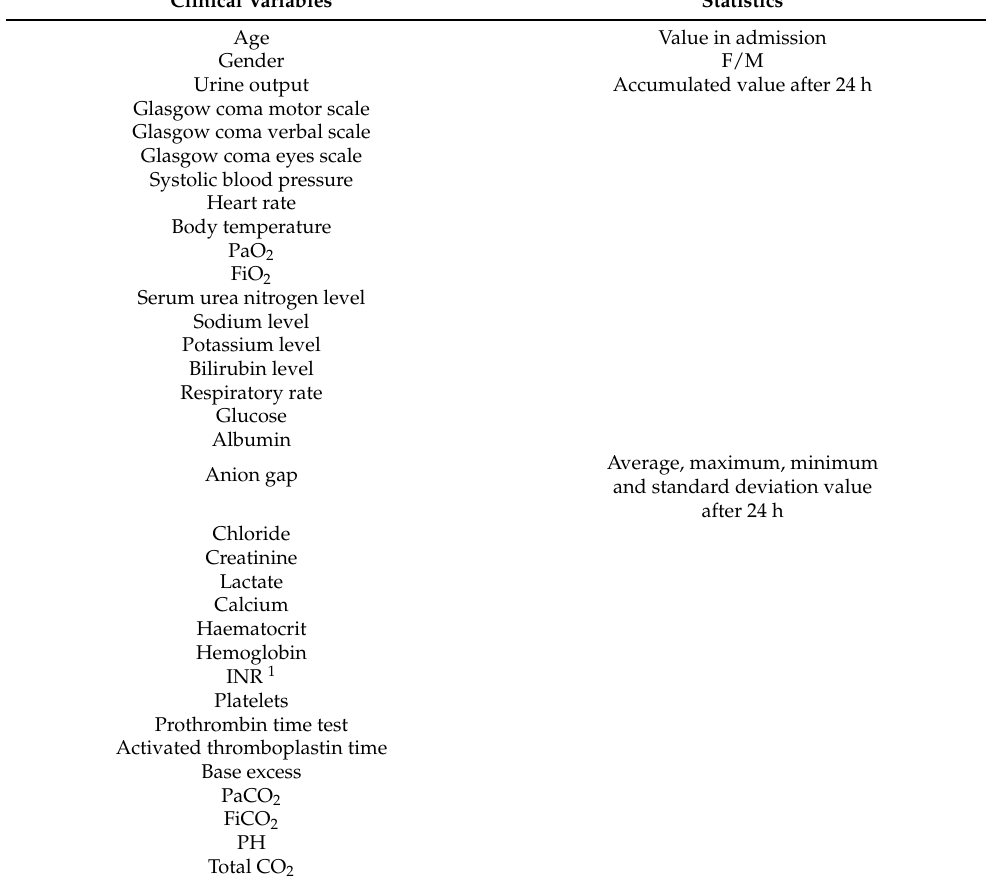
Table 4. Features extracted from each clinical